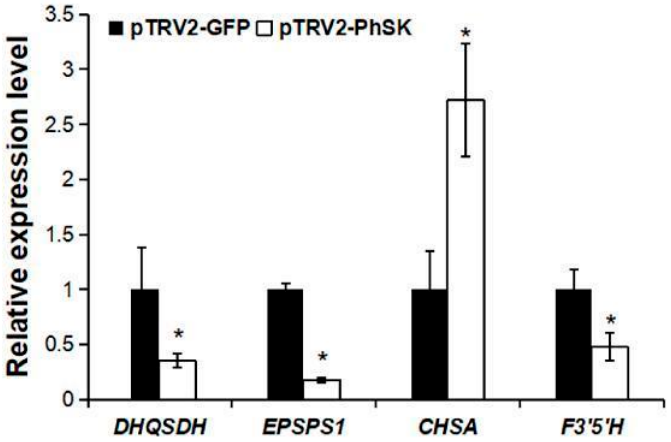
Figure 7. Effects of pTRV2-PhSK treatment on the expression of PhDHQSDH , PhEPSPS1 , PhCHSA , and PhF3 ′ 5 ′ H in corollas. Cyclophilin ( CYP , accession no. EST883944) was used as the internal reference gene for the quantification of cDNA abundance. The data are presented as the means ± SDs (n = 3). The statistical analysis was performed using the one-way analysis of variance (ANOVA) followed by Duncan’s multiple range test (DMRT) with three biological replicates. * indicates significant differences at the p ≤ 0.05 level.